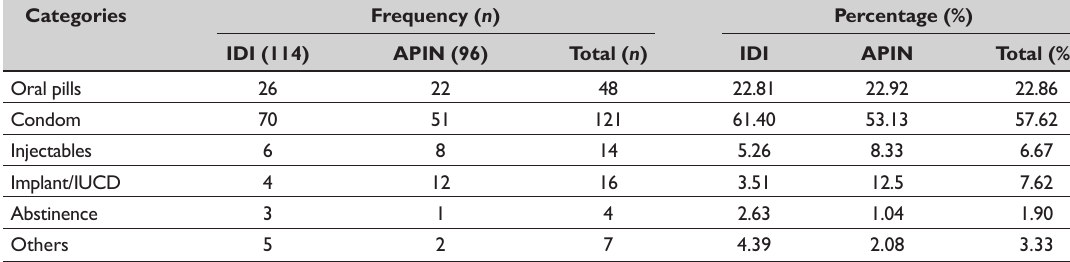
Table 4: Current contraceptive utilization rates among study